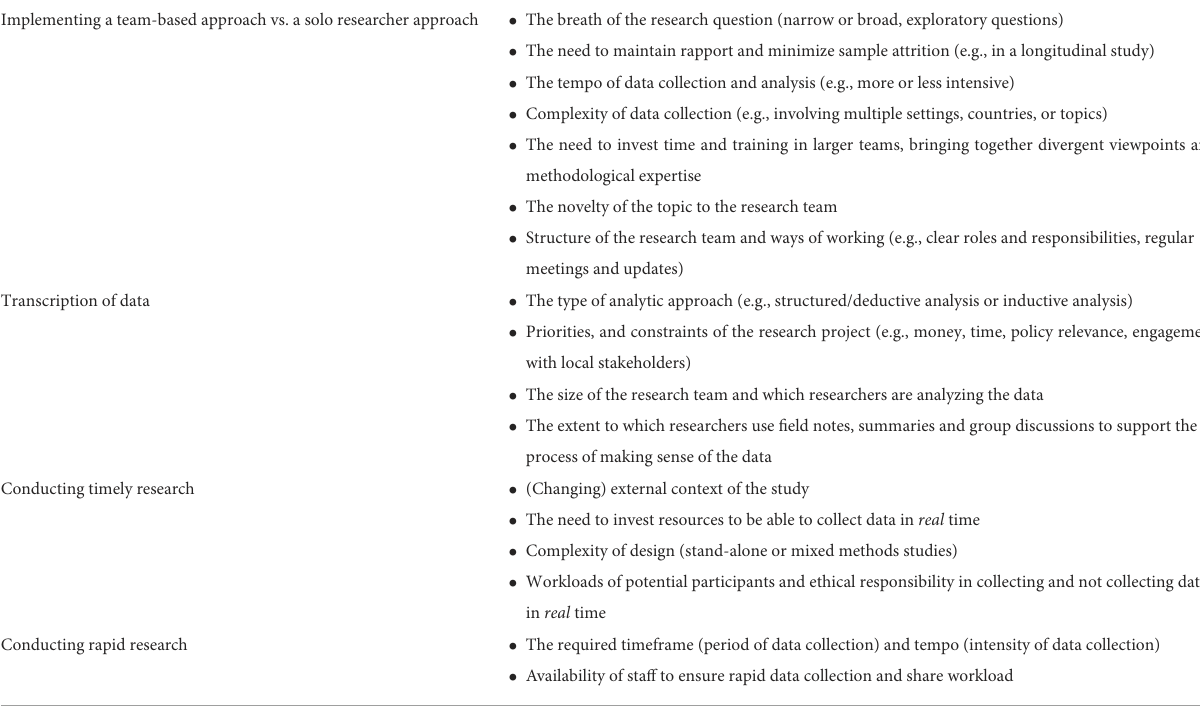
TABLE 2 Summary of key considerations in relation to methodological